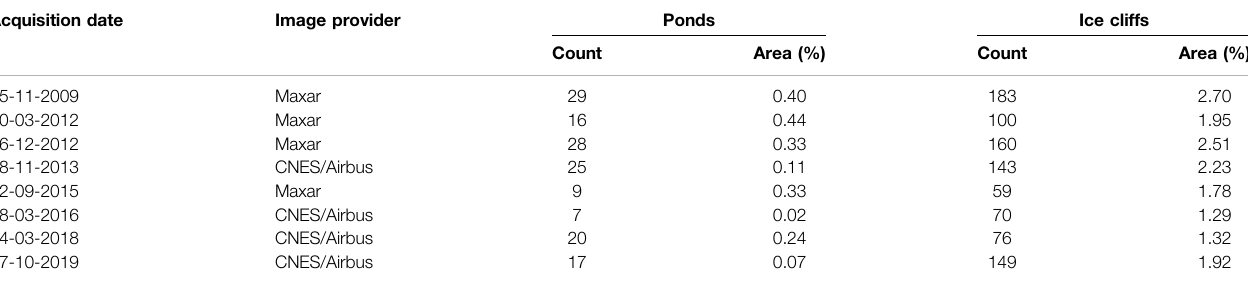
TABLE 2 | Ponds and ice cliffs observations for the 3.05 km 2 debris-covered tongue of Verde